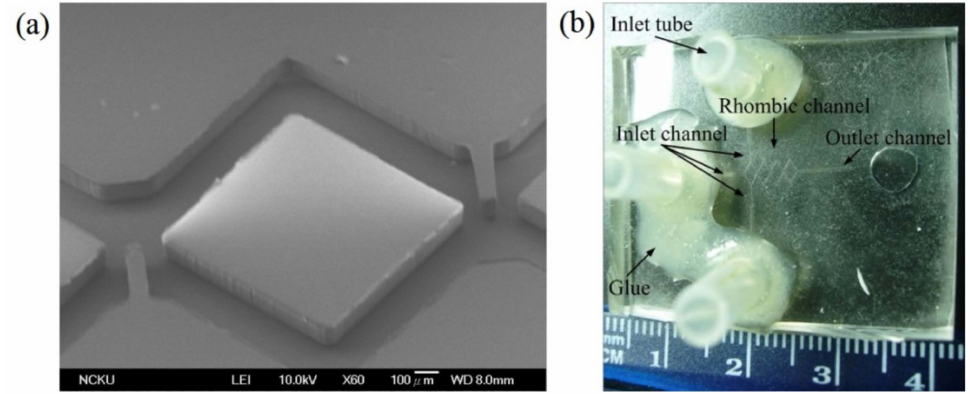
Figure 21. ( a ) SEM image of the PDMS replica layer of the rhombic micromixer with a gap ratio of